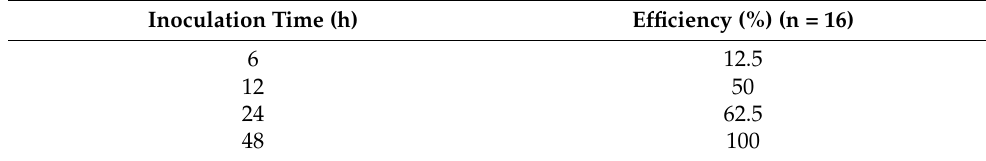
Figure 2. Symptoms and virus detection in A. thaliana inoculated with BrYV by aphids. ( a ) Typical symptoms of purple leaves on A. thaliana plants at 14 days post-inoculation by six viruliferous aphids. ( b ) Western blotting analyses of the accumulation of BrYV MP extracted from A. thaliana upper leaves. Table 4. Minimal inoculation times for viral transmission by six aphids.